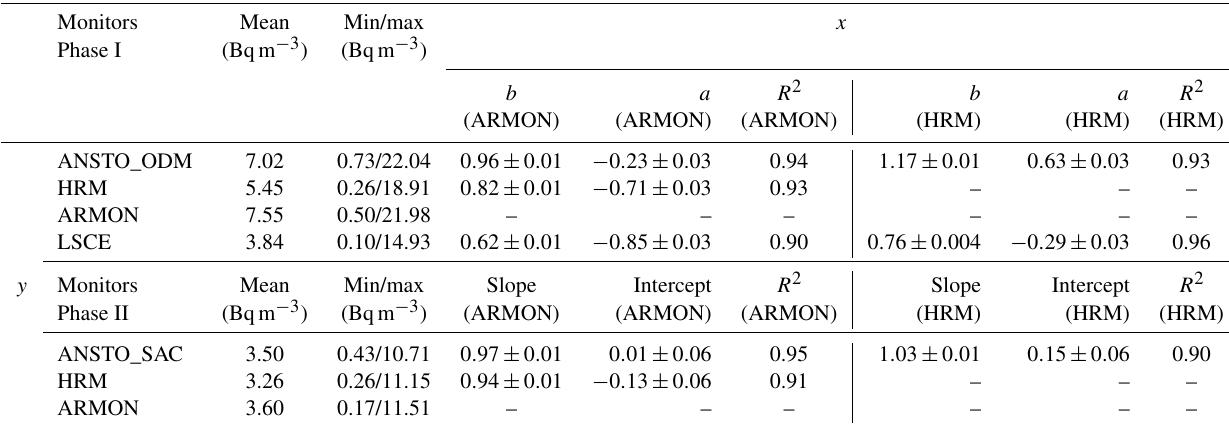
Figure 3. (a) Hourly time series of the atmospheric 222 Rn and 214 Po (HRM) activity concentration measured at the Saclay (SAC) station between 25 January and 13 February 2017 by the ARMON (red circles), ANSTO_SAC (blue circles), and HRM (green circles) monitors. (b) Hourly time series of the atmospheric 222 Rn and 214 Po measured between 7 and 13 February 2017. Table 2. The means, maxima, and minima of the atmospheric 222 Rn and 214 Po activity concentration observed by each monitor participating in Phases I and II of the intercomparison campaigns. The slopes ( b ) and intercepts ( a ) of the linear regression fits calculated between the hourly atmospheric 222 Rn and 214 Po activity concentrations measured by the ARMON and/or the HRM and the other 222 Rn and 222 Rn progeny monitors deployed in both phases are also